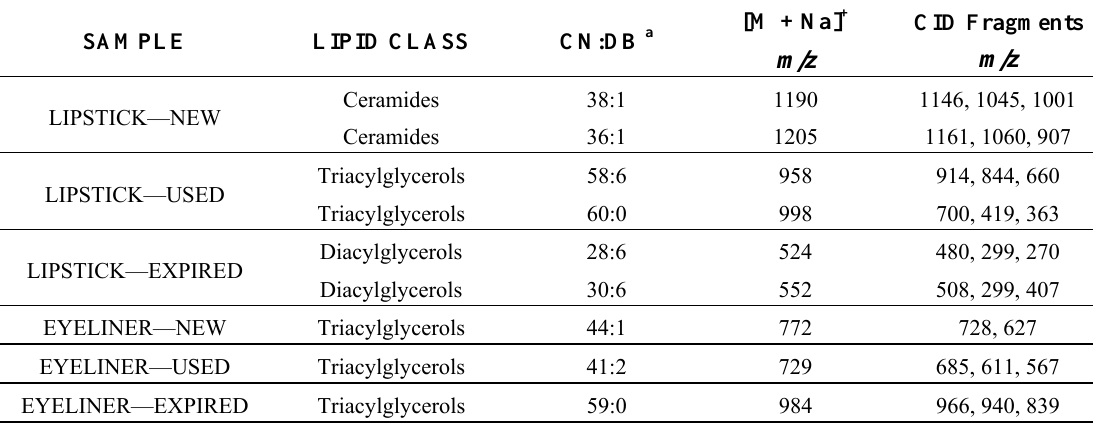
Table 1. Assignment for characteristic ions [M + Na] + of each sample